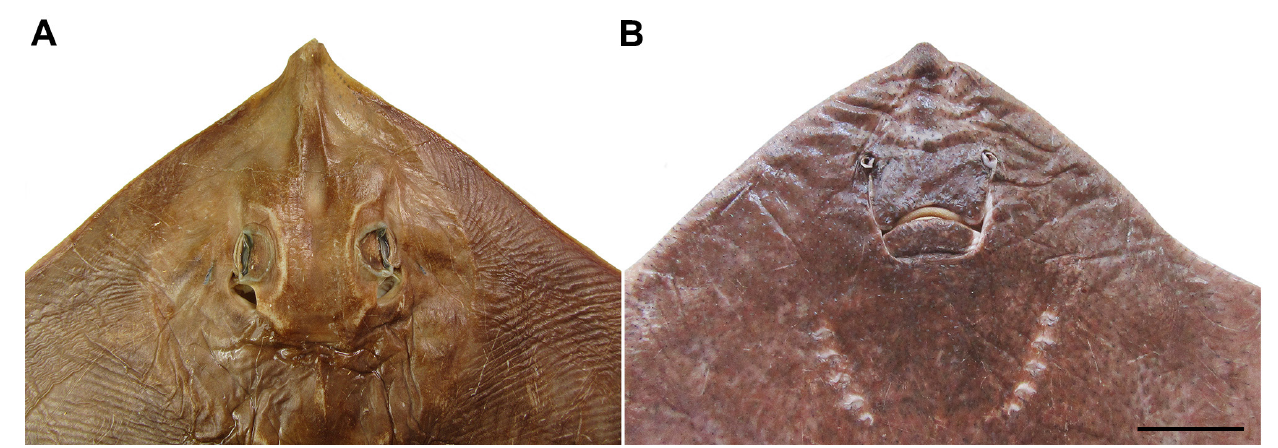
FIGURE 11 | Head region of Atlantoraja platana , UERJ 1383, male, 372 mm TL. A. Dorsal view. B. Ventral view. Scale bar = 10